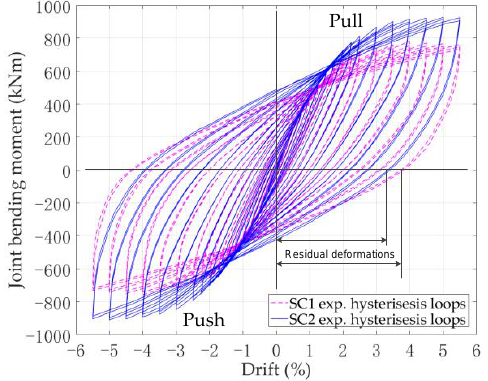
Figure 9. Hysteresis moment–drift response of specimens.